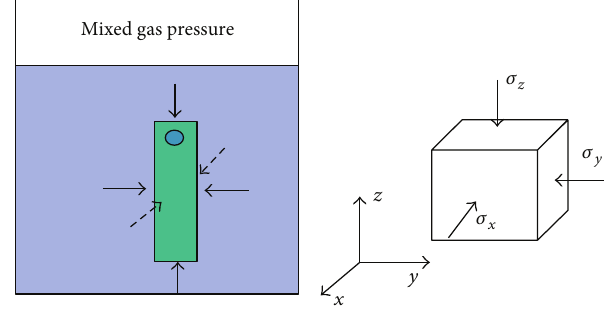
Figure 1: Stress analysis of